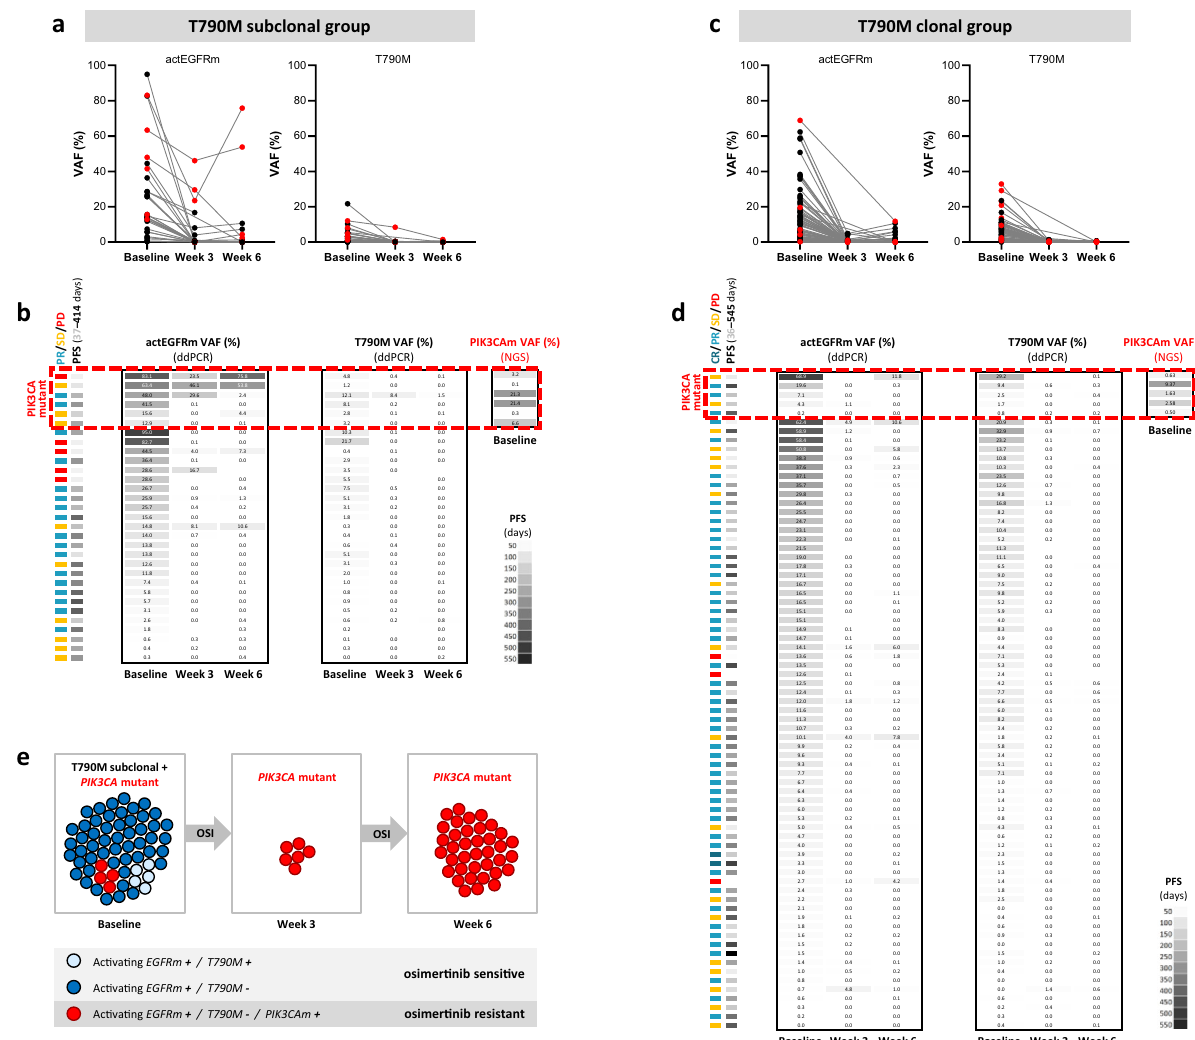
Fig. 4 Changes in EGFR mutation shedding from baseline to week 6 in osimertinib-treated patients with clonal or subclonal T790M assessed by ddPCR. a , c Serial plasma ctDNA analysis of activating EGFR mutation (left) and EGFR T790M (right) shedding at baseline, week 3 and week 6 of treatment with osimertinib in 31 patients from the T790M subclonal cohort ( a ) and 73 patients from the T790M clonal cohort ( c ). The VAFs were determined by a ddPCR assay. Patients with PIK3CA mutant baseline plasma (detected by NGS) are highlighted in red. b , d Association of activating EGFR mutation (left) and EGFR T790M (right) VAF with clinical response in 31 patients from the T790M subclonal cohort ( b ) and 73 patients from the T790M clonal cohort ( d ). Patients with PIK3CA mutant baseline plasma (previously detected by NGS) are marked by a red rectangle and the highest detected VAF of actionable PIK3CA mutations in marked patients is shown. Tumour response (assessed according to RECIST criteria) categorised into CR complete response, PR partial response, SD stable disease, PD progressive disease, PFS progression-free survival. e A hypothetical schematic model of clonal evolution of the EGFRm + /T790M − /PIK3CAm + cell population (in red) from baseline until 6 weeks of treatment with osimertinib. Because osimertinib targets both the activating EGFRm and T790M, cells harbouring only these two driver mutations are quickly diminished by the treatment, whereas EGFRm + /T790M − /PIK3CAm + cells are expected not to respond to osimertinib that could drive resistance to osimertinib in these patients. OSI